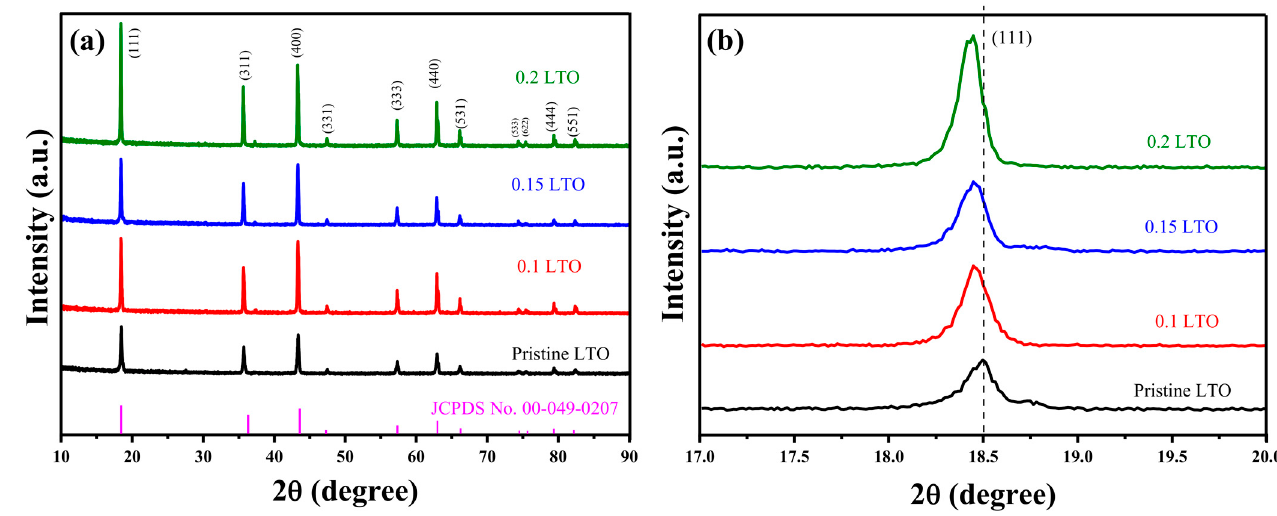
Figure 1. ( a ) XRD pattern of pristine and iodide-doped LTO and ( b ) magnification of (111) peaks of pristine LTO and iodide-doped LTO.